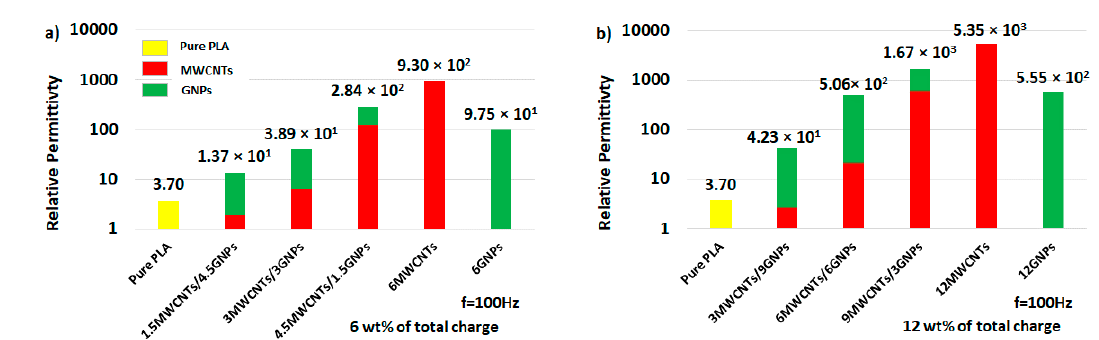
Figure 17. Comparison of the real part of the permittivity evaluated at the value of 100 Hz for hybrid composites filled with 6 wt % and 12 wt % of total charge in ( a ) and ( b ), respectively.